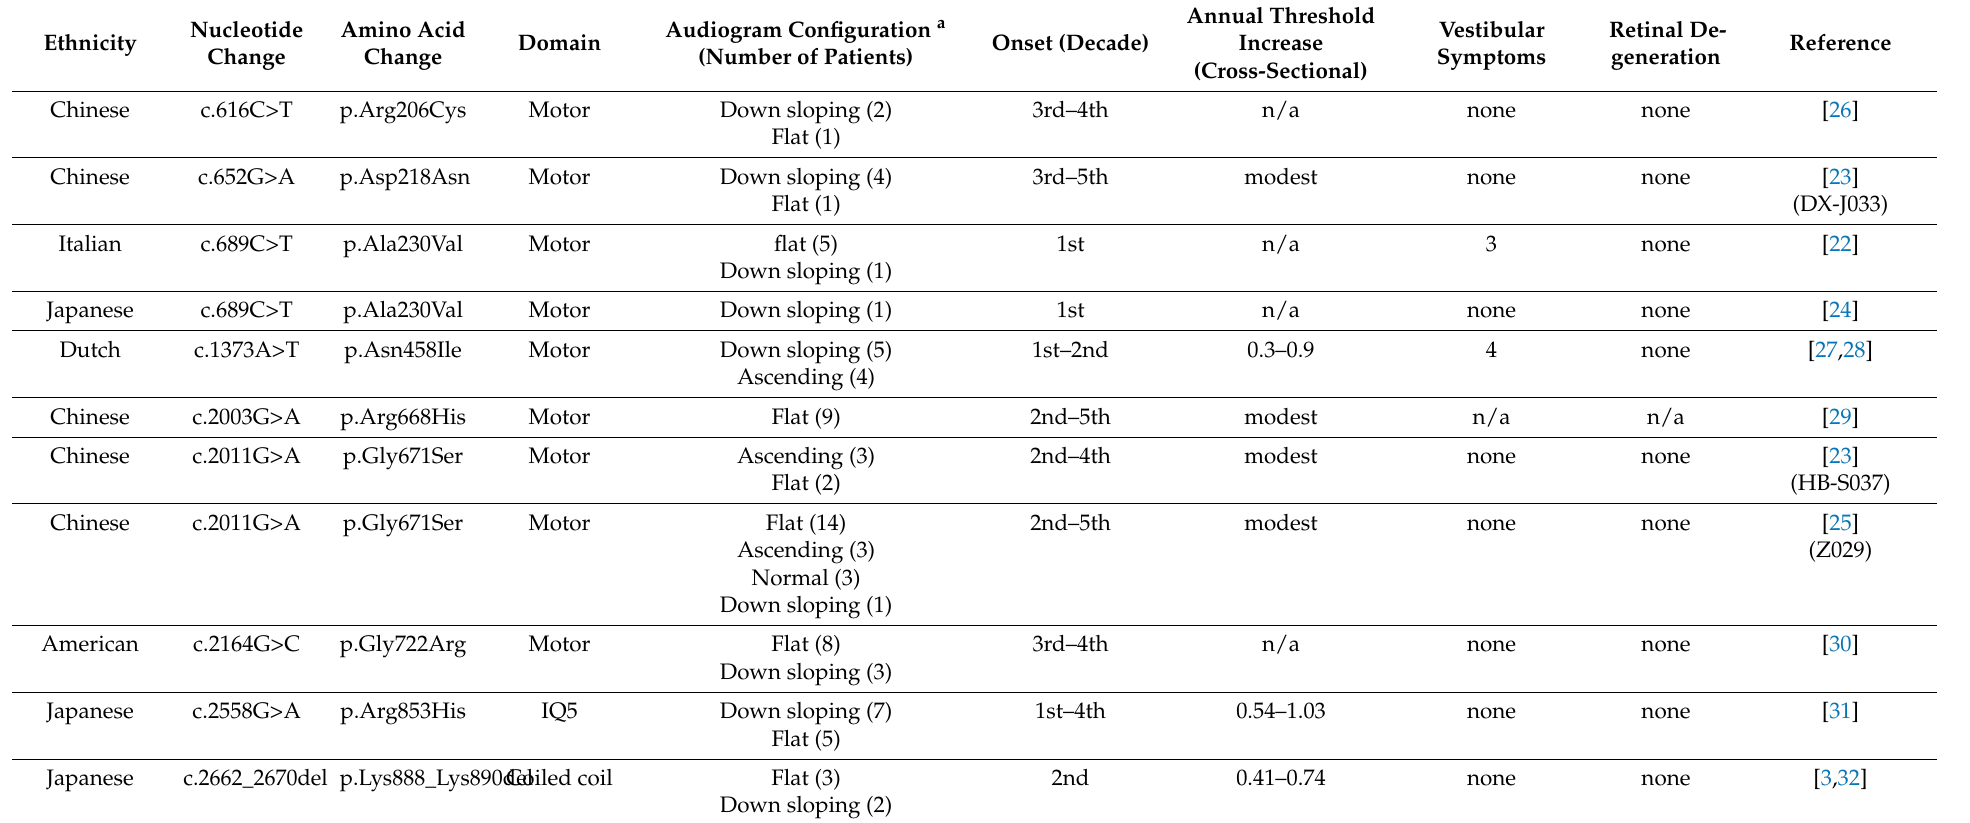
Table 3. MYO7A variants associated with DFNA11 in the